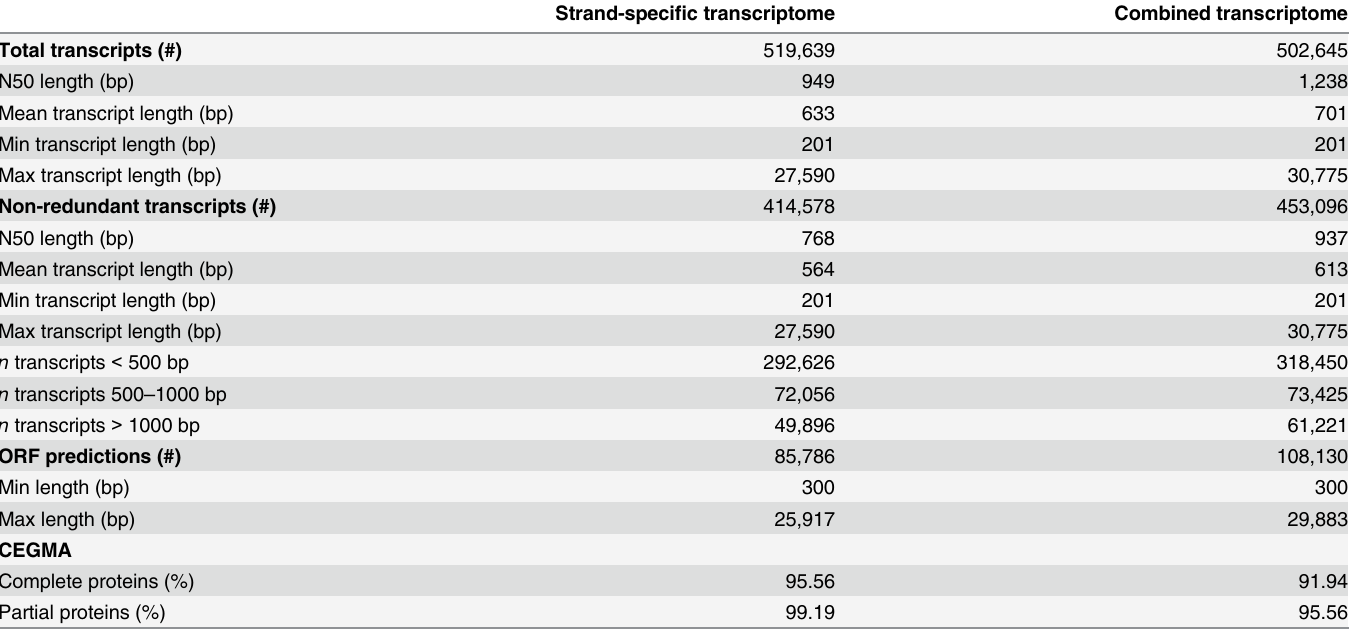
Table 1. Summary of S . glomerata assembly, ORF prediction and CEGMA